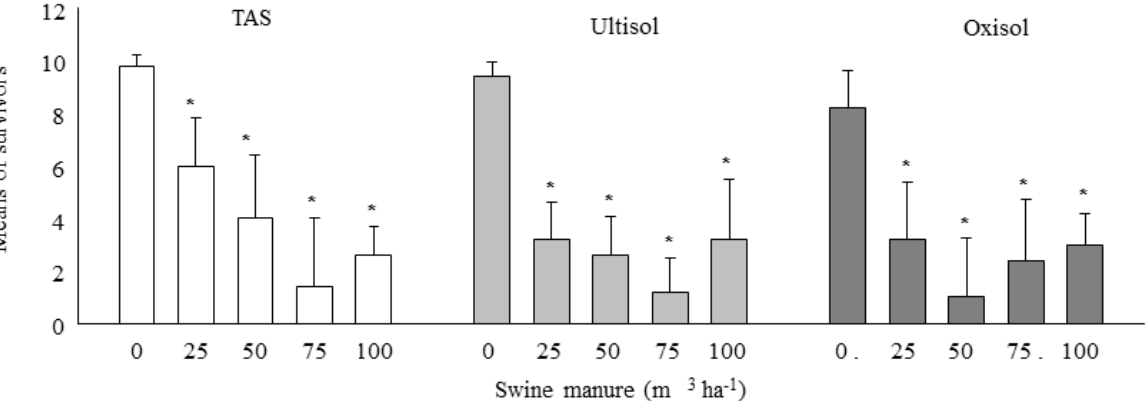
Figure 1. Means of Folsomia candida individuals surviving in Tropical Artificial Soil (TAS), Ultisol and Oxisol with increasing concentrations of swine manure. *Significant statistical difference (p<0.05) by the Dunnett test. ( ┬ ). Standard deviation (n =